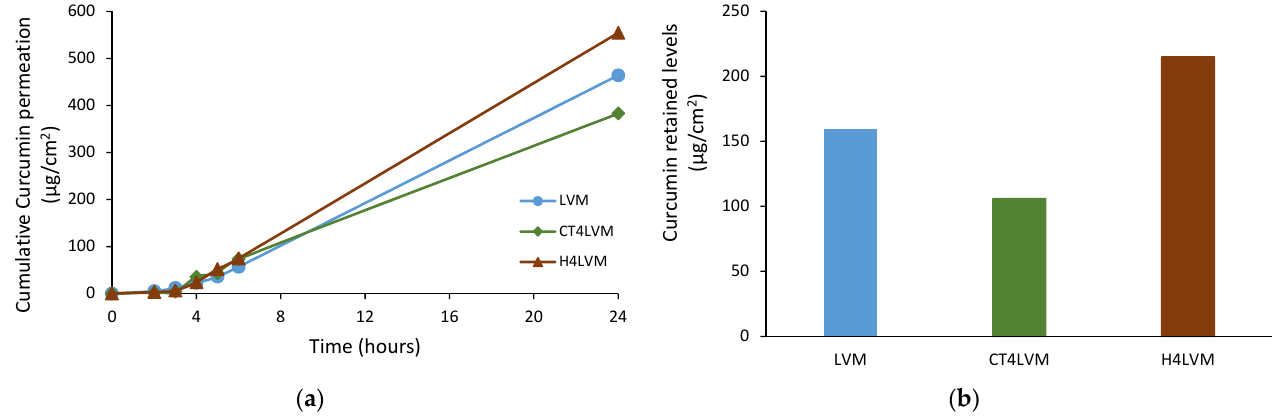
Figure 7. In vitro permeation of Curcumin from microemulsion and gel microemulsions through the Strat-M ® membrane ( a ) and the total Curcumin retained in the membrane after 24 h ( b ).